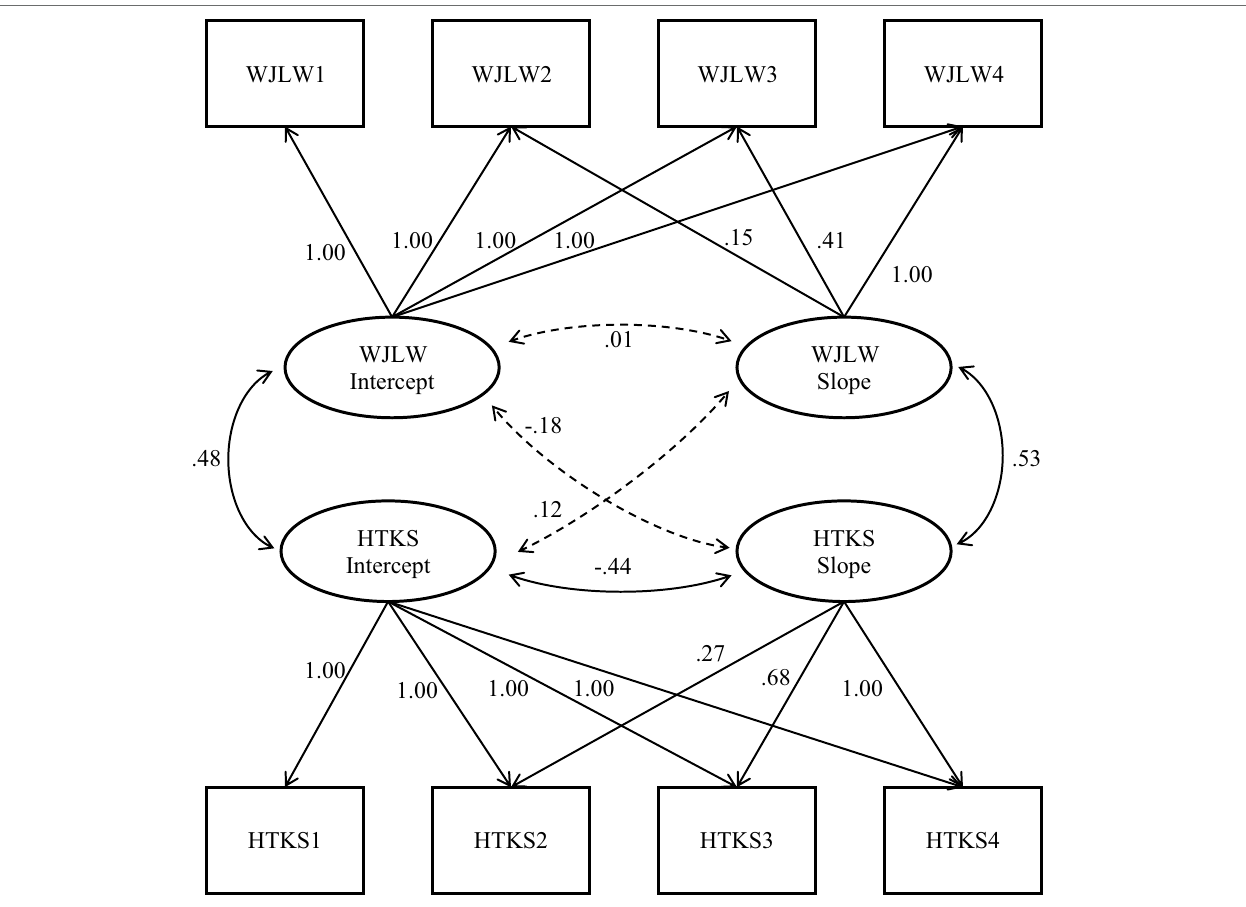
FIGURE 1 | Literacy and HTKS-R parallel process model. Values represent unstandardized factor loadings and standardized covariances. Significant covariances and factor loadings at p < 0.05 are displayed with solid lines. Non-significant loadings are displayed with dashed lines. Analyses revealed the following model fit indices: CFI = 0.961; TLI = 0.954; AIC = 14363.732; BIC = 14433.094; RMSEA = 0.064; χ 2 (24) = 47.342, p = 0.003. WJLW = Woodcock Johnson Letter-Word subtest. HTKS-R, Head Toes Knees Shoulders –